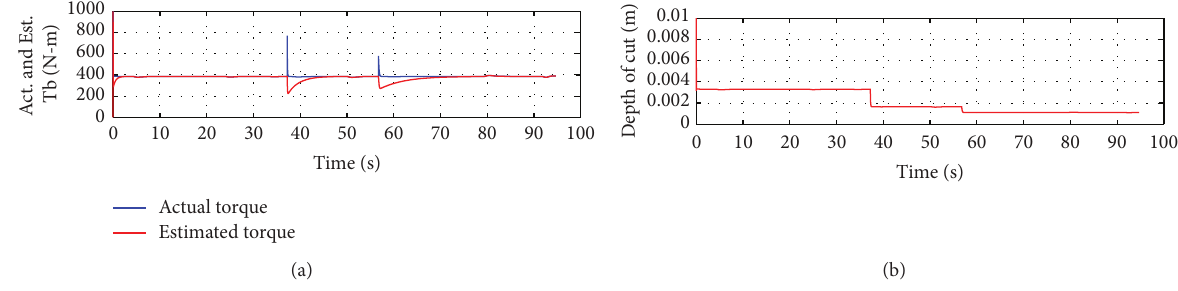
̂𝑇(𝑡) (𝑡) (a); depth of cut 𝑑 cut